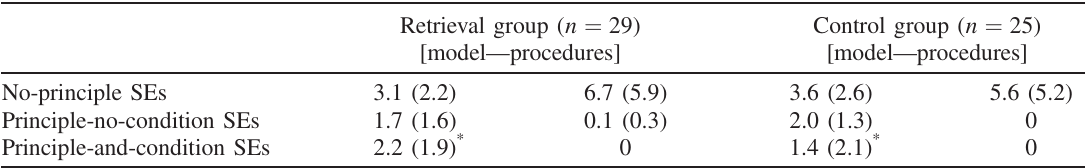
Table VII, with þ 1 point for each of the observable actions, for a total of 22 possible points. V. G. and V. H. P. scored 10% of the problem-solving post-tests, with an interrater agreement of 97% and Cohen ’ s unweighted kappa ¼ 0 . 93 , TABLE IX. The mean number (SD) of self-explanation categories for the physics model and mathematical procedures for the retrieval group and the control group. Note that N ¼ 54